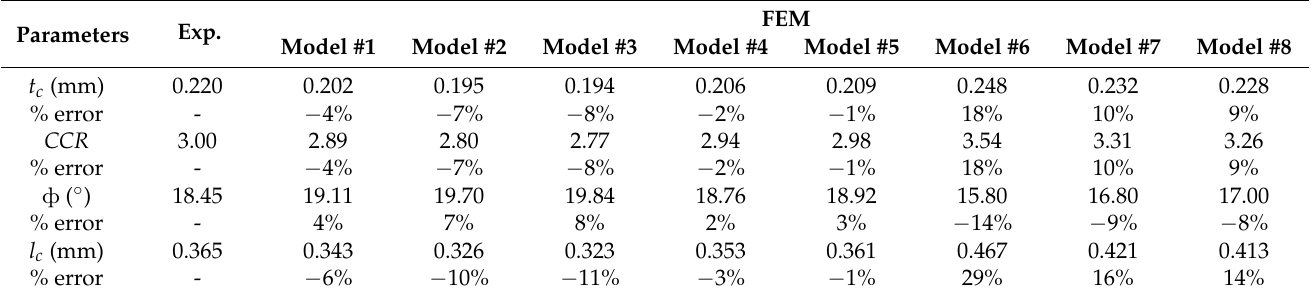
Table 4. Chip thickness ( tc ), chip compression ratio ( CCR ), shear angle ( ф ), and contact length ( lc